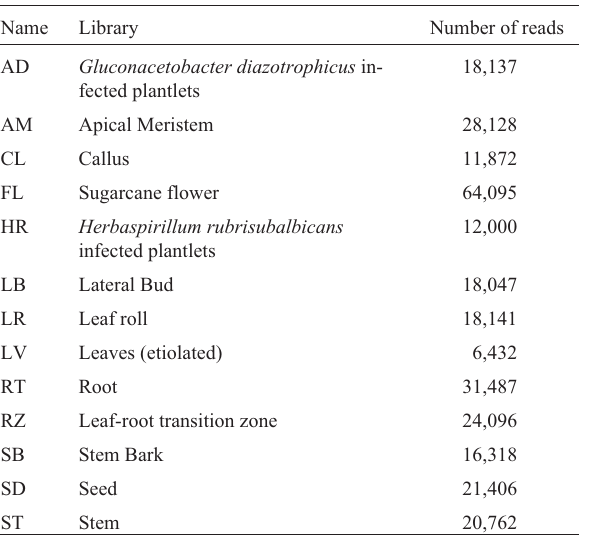
Table I - Identification of SUCEST libraries.